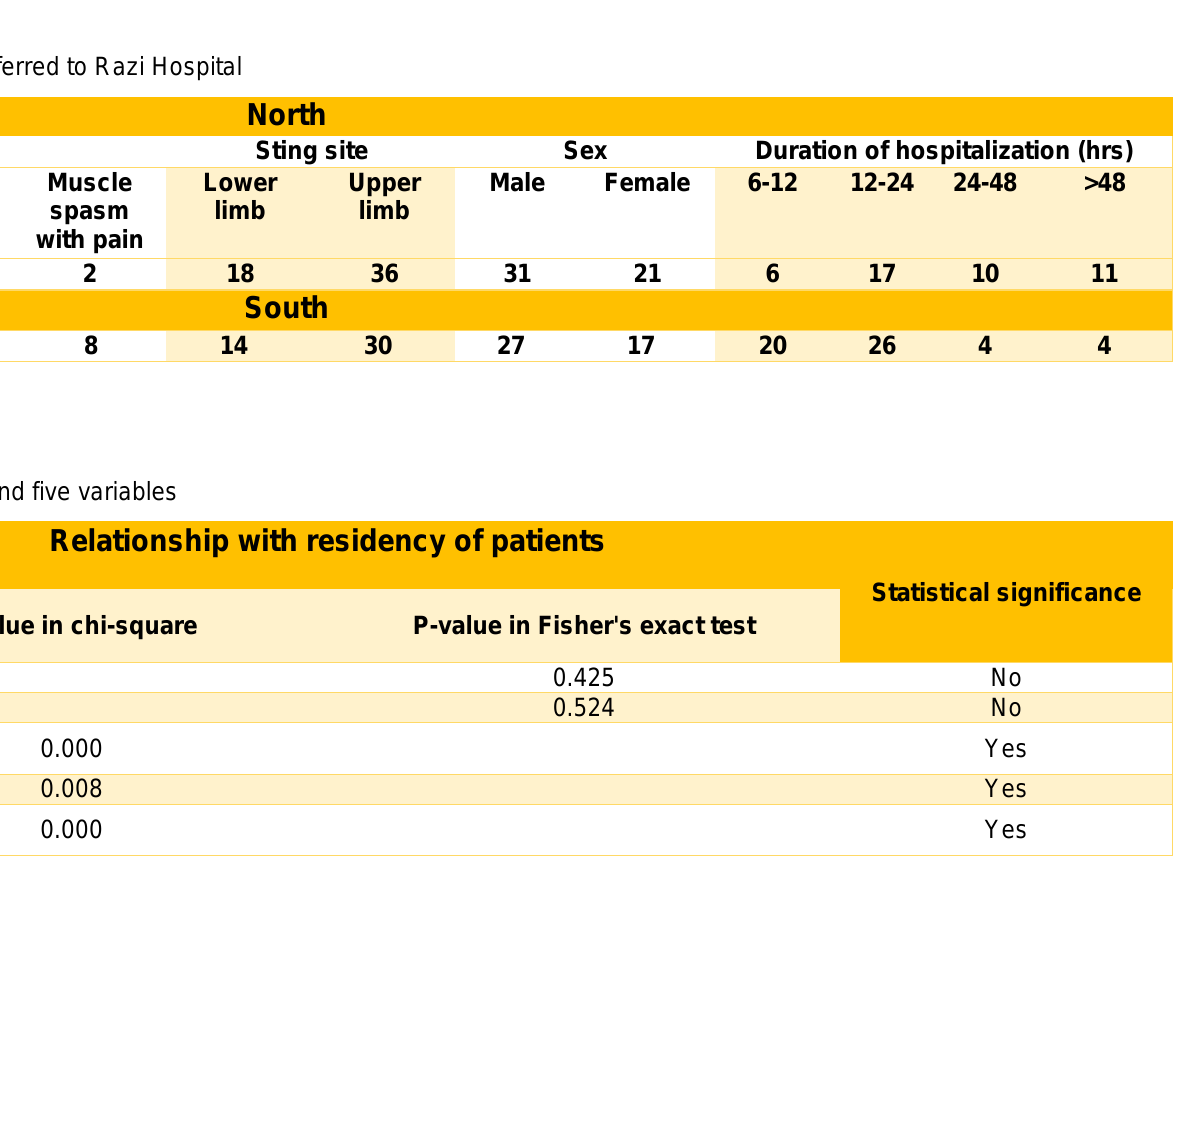
Table 1: Data from stung people by A. crassicauda referred to Razi Hospital N of doses of calcium Sign Sting site Sex